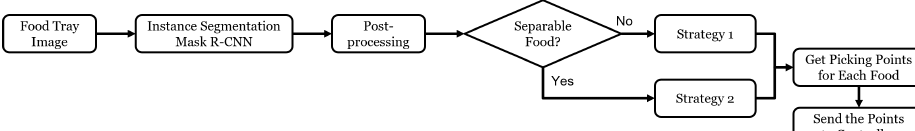
Figure 6. The flowchart for food acquisition point estimator.